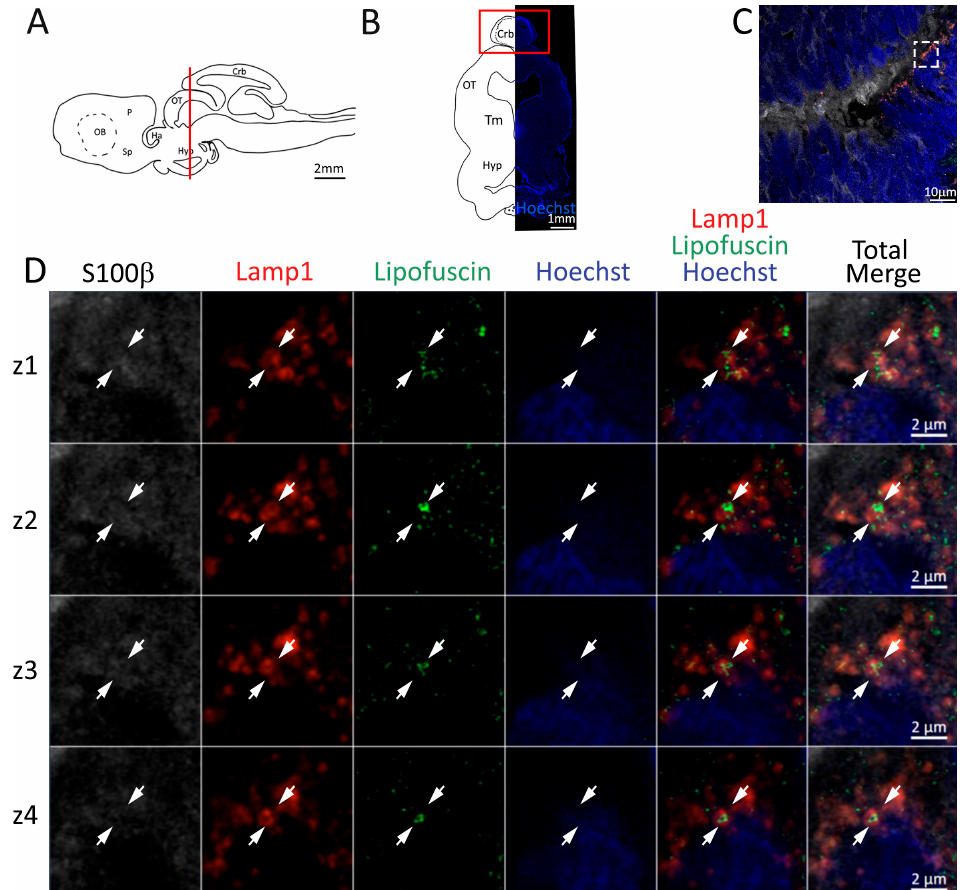
Figure 16. Presence of lipofuscin aggregates inside lysosomes in the anterior cerebellum of S. canicula . ( A ) Sagittal representation of S. canicula brain. The red line indicates the rostro-caudal localization of the section represented in the panel. ( B ) Coronal map of the area imaged. On the right, a real coronal section is stained with Hoechst 33342 to show nuclei distribution; on the left, a cartoon is drawn to indicate anatomical references. Red rectangle identifies the general area from which images are taken. ( C ) Area of the neurogenic niche where magnifications are taken from. ( D ) Lysosomes (Lamp1, red) containing lipofuscin aggregates (green). In the panel, four consecutive z planes are represented (z1–z4) to render the three-dimensionality of the inclusion. Each plane is acquired at 1 μ m step in the z-axis from the previous. Last column represents the overlay of all four channels. White arrows indicate the localization of lysosomes containing lipofuscin. Abbreviations: Crb: cerebellum,